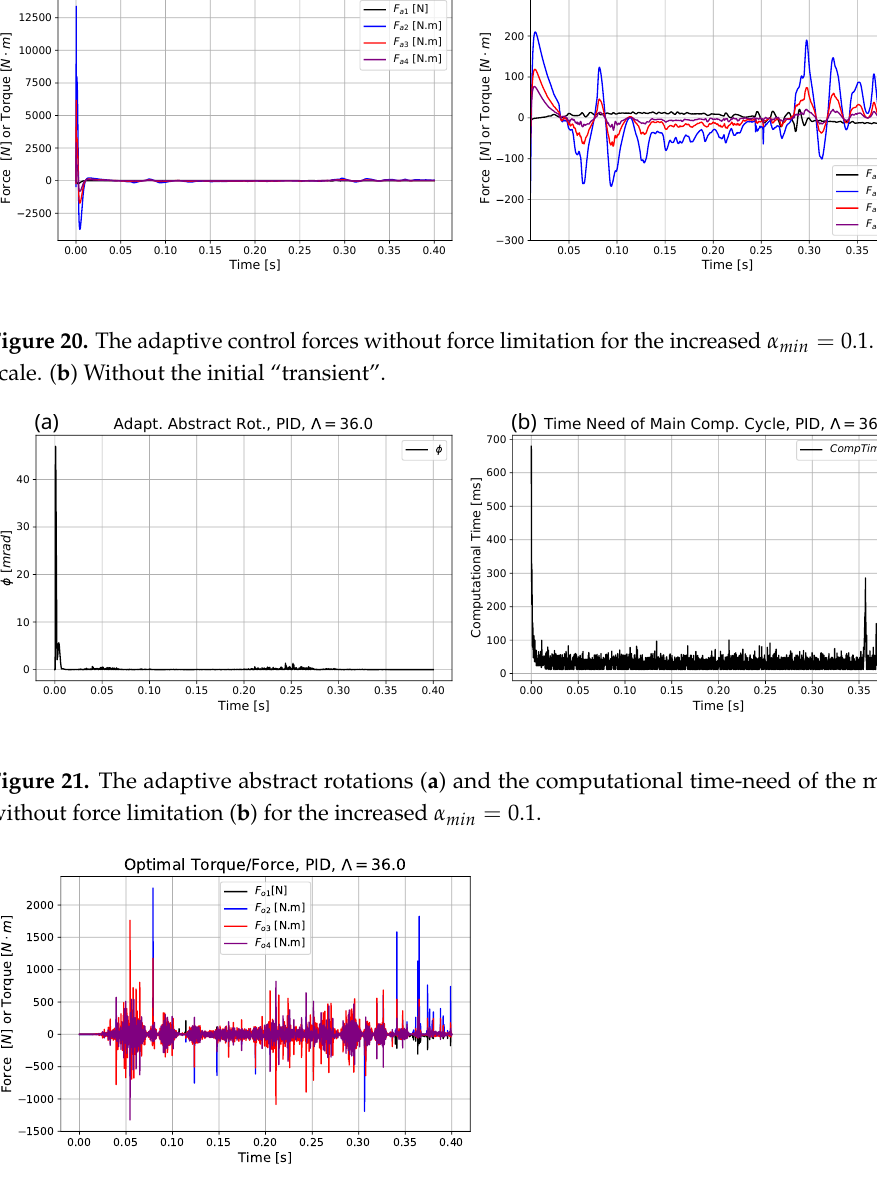
Figure 22. The optimal forces without force limitation for the increased α min =